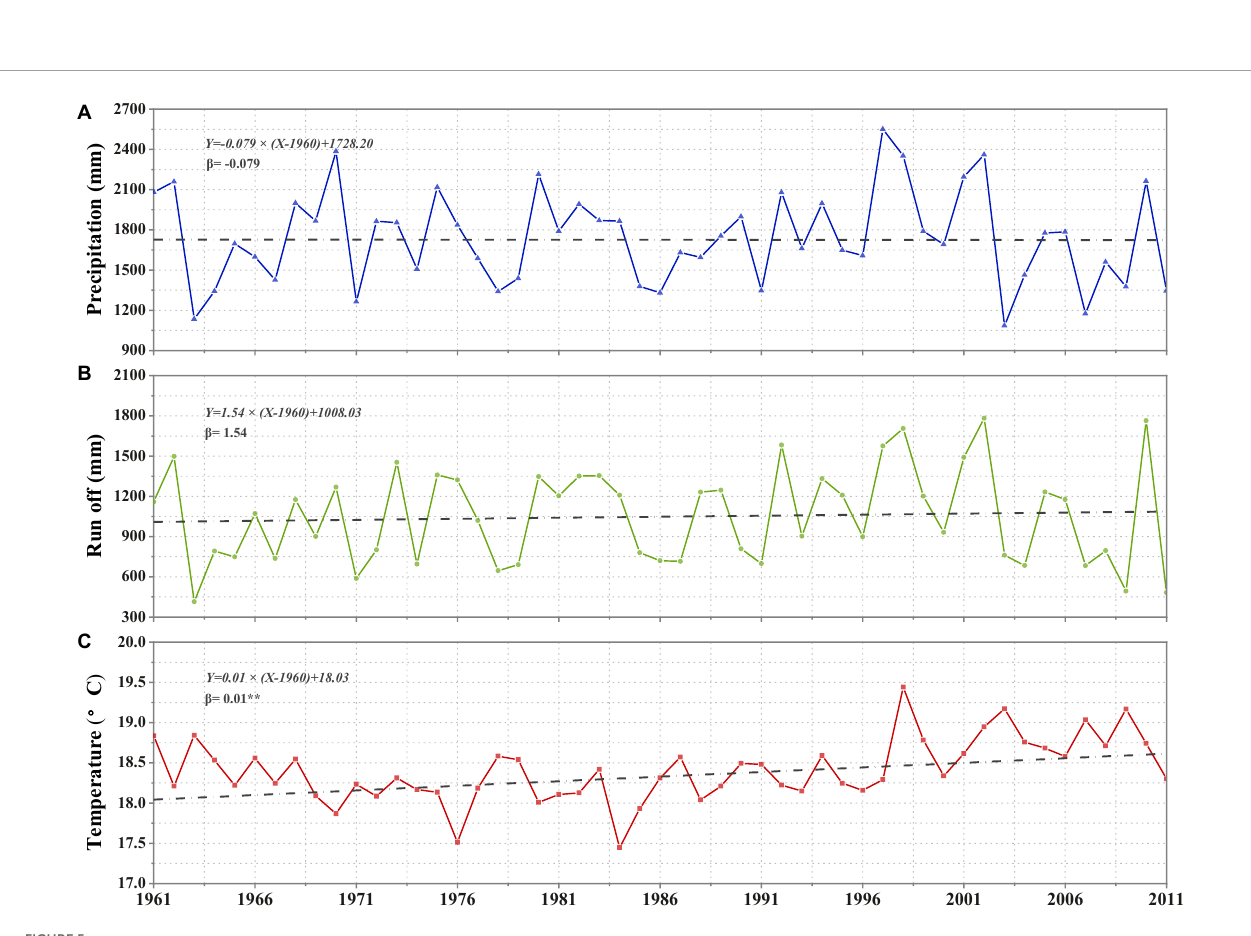
Frontiers in Forests and Global